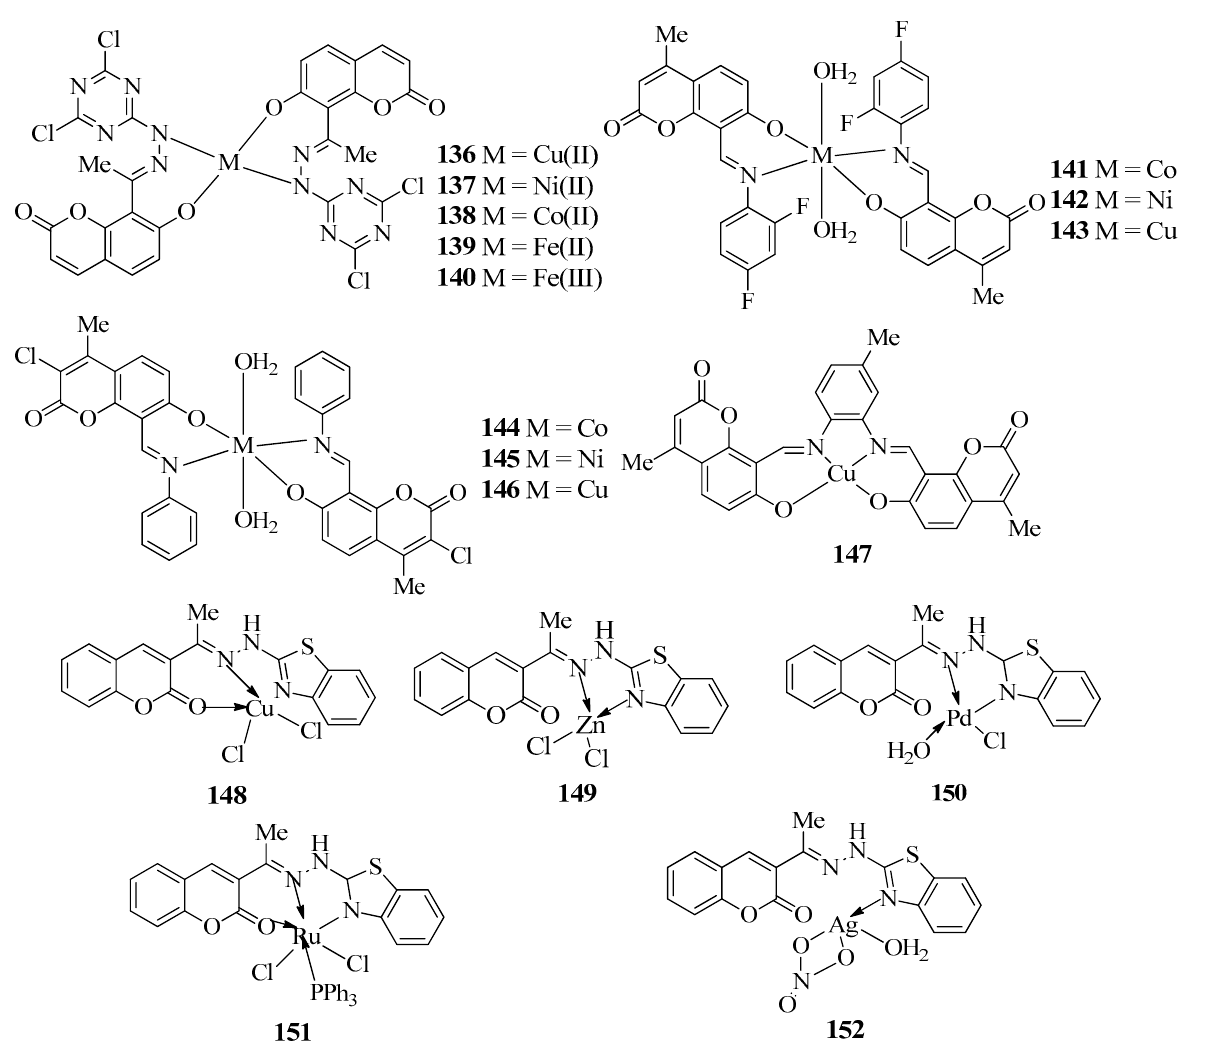
Figure 5. Structures of coumarin-derived imine–metal complexes ( 77–152